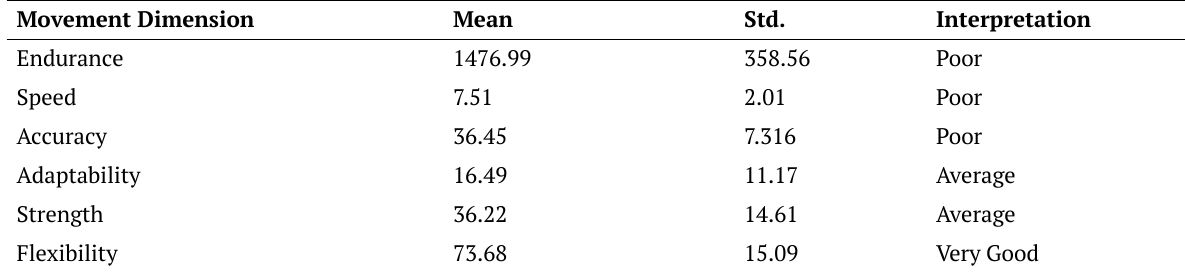
Table 6. Level of movement capability of the participants Movement Dimension Mean